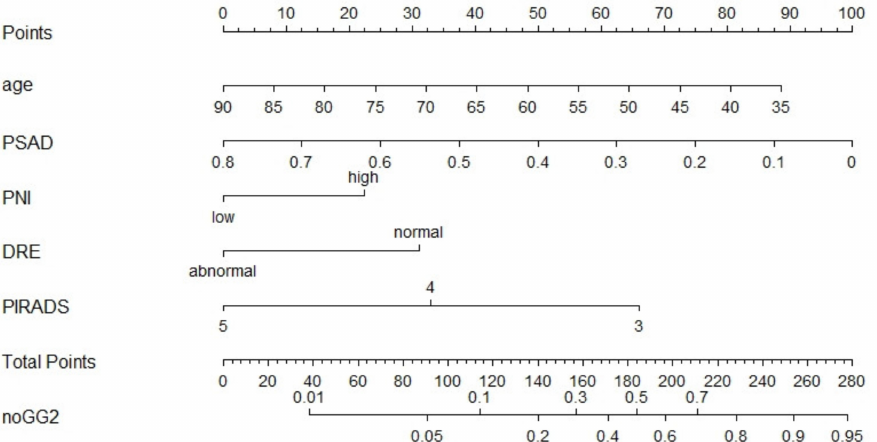
Figure 3. Pre-biopsy nomogram based on the multivariable logistic regression model with PNI pre- dicting benign pathology or GG1 disease in patients with PI-RADS ≥ 3 lesions undergoing systematic and targeted biopsy. Instructions for physicians: Locate the patients status on the corresponding axis. Draw a straight line to determine how many points the patients should receive for each variable. Sum the points received and locate the number on the total points axis. Draw a line down from total points to the noGG2